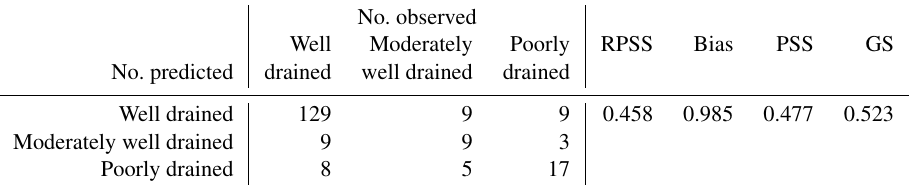
Table 5. Frequency of drainage class levels and predictions of respective outcomes by geoGAM for the 198 sites of the validation set (No.: number of sites per response level, RPSS: ranked probability skill score, bias: mean bias ratio, PSS: Peirce skill score, GS: Gerrity score for ordered